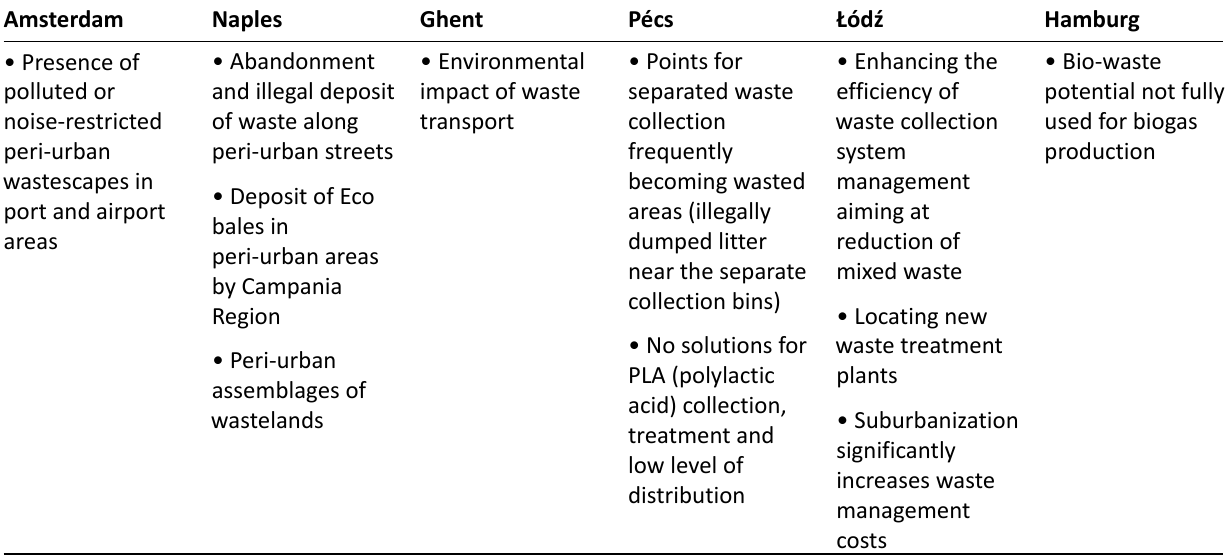
Table 6. Governance challenges: